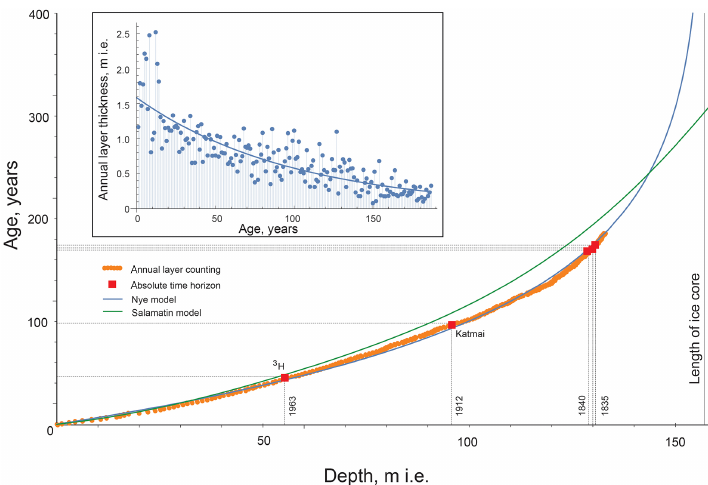
Figure 9. Depth (ice equivalent in m)/age relation established for the Elbrus ice core by annual layer counting along the depth profile using ionic species (orange dots), and applying the ice flow models: Nye (blue line) and Salamatin (green line). The insert represents the annual layer thickness (ice equivalent in m) and the Nye least square fit (see